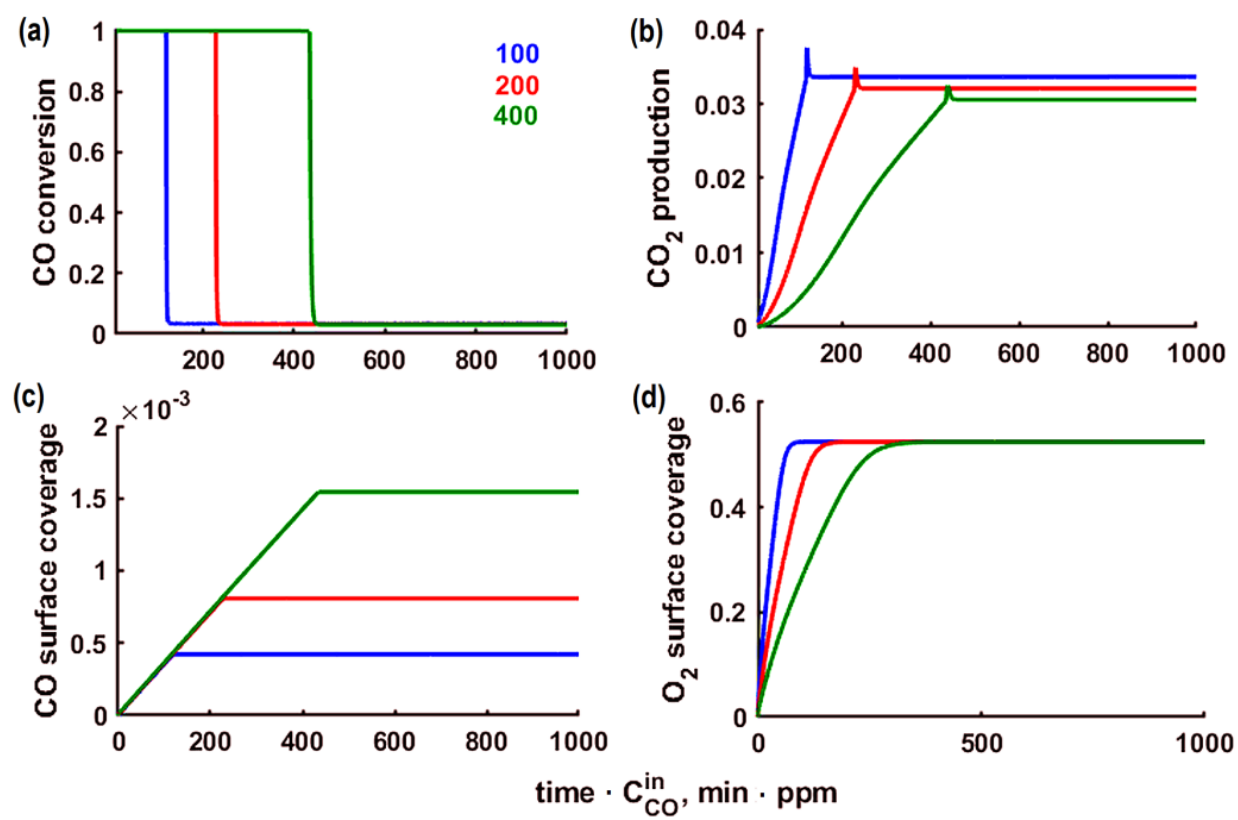
Catalysts 2023 , 13 , x FOR PEER REVIEW 21 of 24